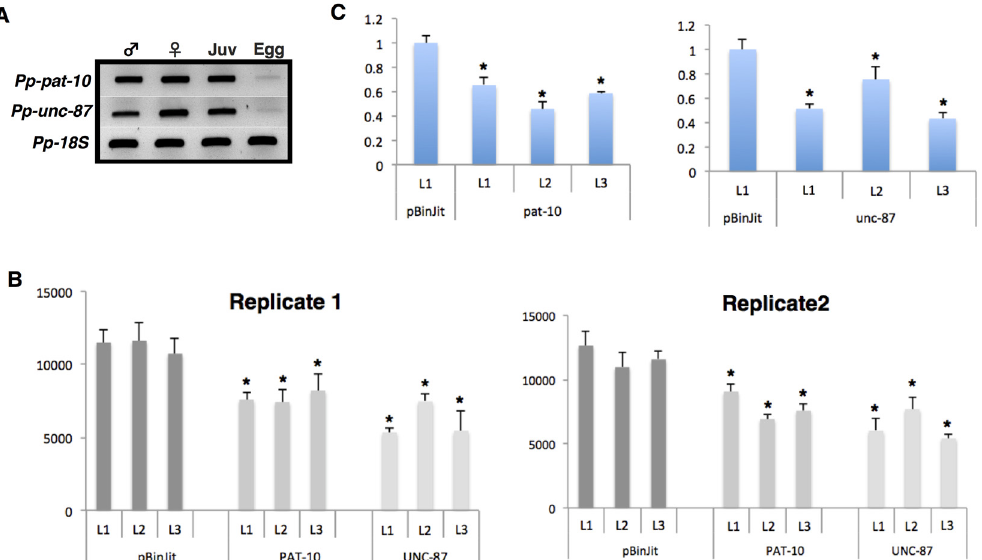
Fig 2. Effect of root RNAi-mediated silencing nematode genes on development and reproduction of Pratylenchus penetrans . (A) Semi-quantitative RT-PCR expression of Pp-pat-10 and Pp-unc-87 from mRNA of differential nematode stages (eggs, juveniles and adult stages). (B) Nematode challenge assays in transgenic soybean dsRNA hairy root lines 3 months after infection. Data shown represent the total mean number ± SEM of nematodes recovered from roots, using a pool of nine soybean hairy roots for each line. Replicate 1 and replicate 2 correspond to two independent biological assays, using the same hairy root lines. As control, hairy roots transformed with an empty vector (pBinJIT) were used. Asterisks denote statistically significant differences using Student ’ s t- test (P < 0.05). (C) Transcript levels of P . penetrans targeting genes that develop in the dsRNA expressing transgenic soybean hairy root lines. The expression levels were quantified as fold change values calculated by the 2 - ΔΔ Ct method, using 18S rRNA gene as reference. Each bar represents the mean with standard error of two independent biological replicates, using three technical repetitions. Asterisks denote statistically significant differences using Student ’ s t- test (P <